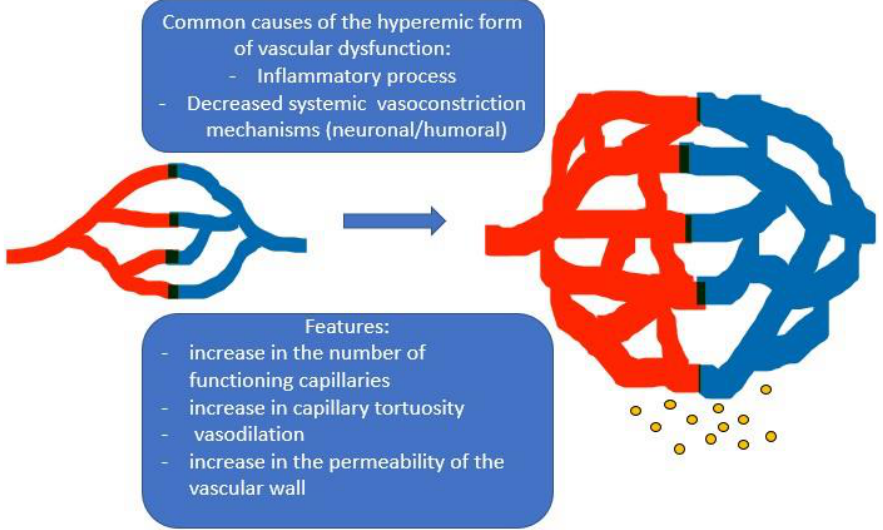
Figure 3. Features and common causes of the hyperemic form of microvascular dysfunction.